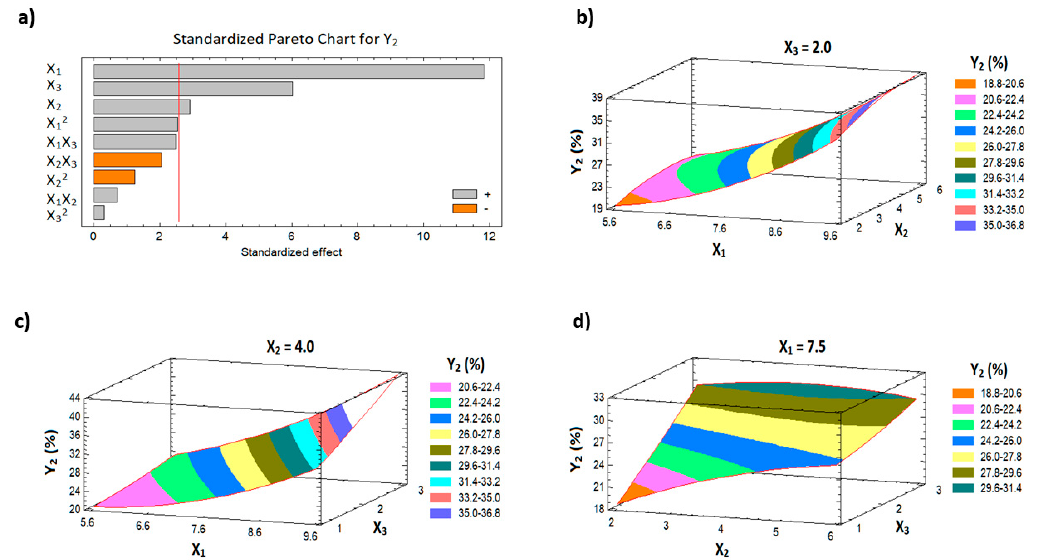
Figure 2. Pareto chart ( a ) and response surface plots ( b – d ) for Y 2 .